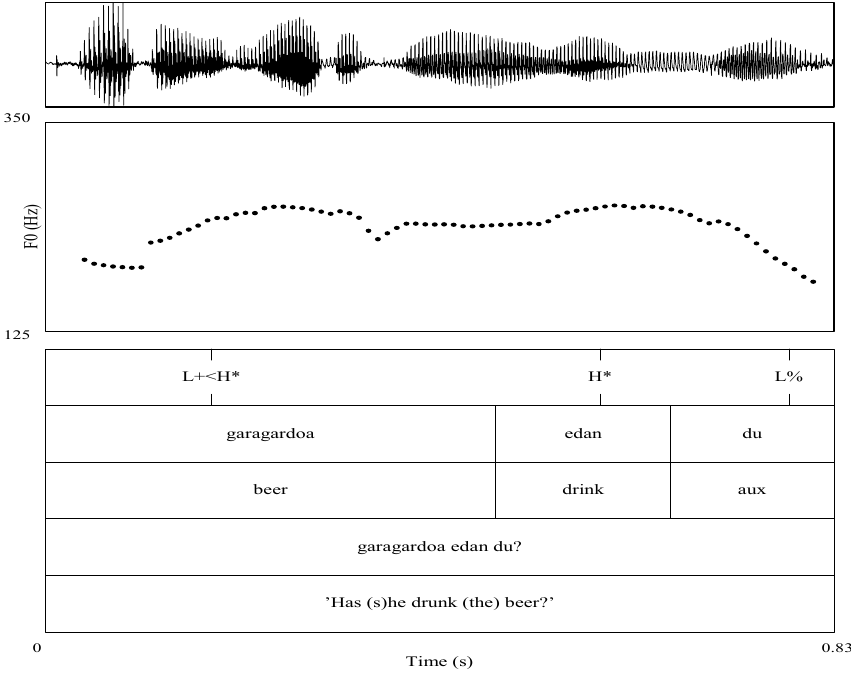
Figure 2. F0 contour of an absolute interrogative statement in Gipuzkoan Basque by a female speaker (example from (Elordieta and Hualde 2014, p. 457)).